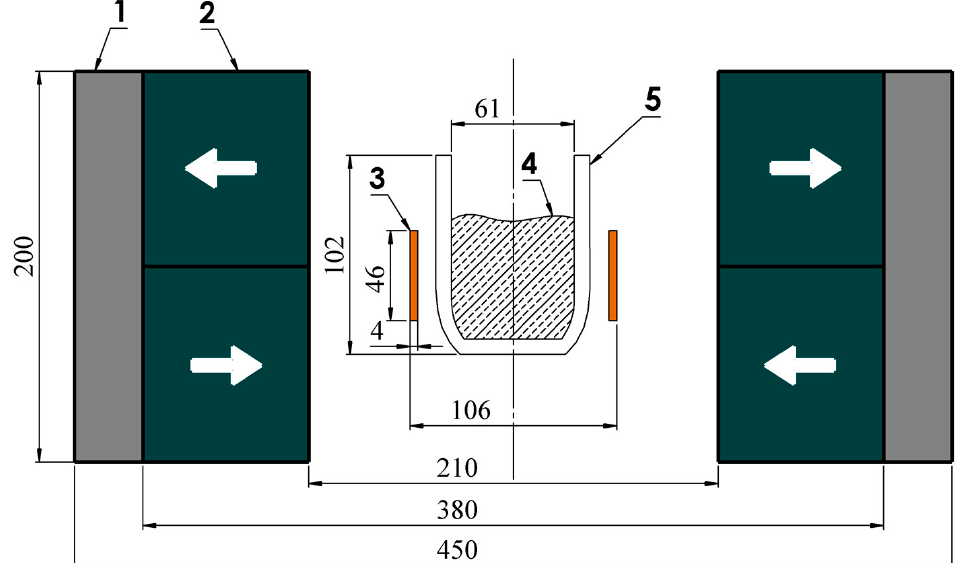
Figure 1. Principal scheme (axial symmetry) of the experimental setup. The setup dimensions are shown in mm. 1-steel magnetic field concentrators. 2-permanent magnet assembly, white arrows show magnet magnetization. 3-copper inductor. 4-liquid aluminum alloy. 5-graphite crucible. The inductor is fed from the capacitor bank discharge and creates a pulsed magnetic field. The electrical scheme of the pulsed magnetic field source is shown in Figure 2A. PMF is generated by capacitor C discharge through inductor L. The AC transformer U in circuit diodes charges the capacitors. The control block with thyristor switches S and regulates the charging, pause, and discharge time. The measured peak current during the capacitor discharge through the inductor is 40 kA, as shown in Figure 2B. the pulse oscillation period is 1 ms. The pulse period has been divided into 6 stages of interest: 1-initial, 2-ramp-up, 3-top peak, 4-ramp-down, 5-zero cross, and 6-bottom peak. These stages are later described in the numerical model.